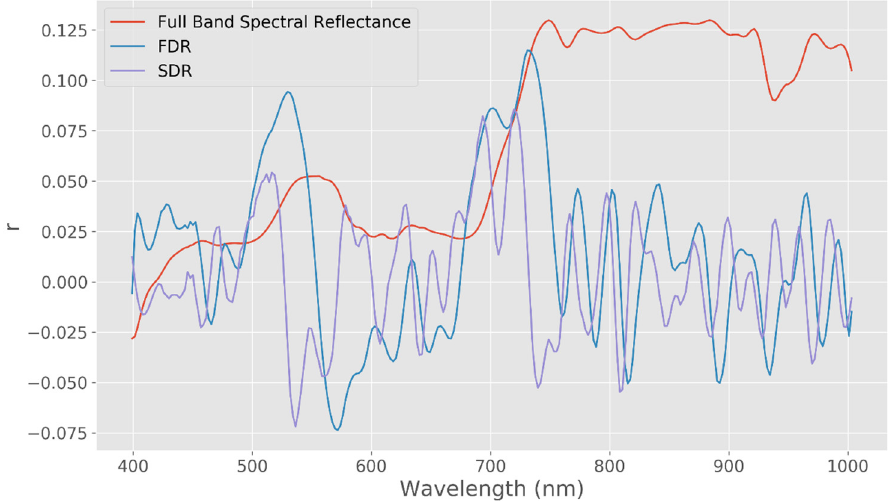
Figure 4. Pearson correlations between the spectral information and maize grain yield. The correla- tions were calculated for each spectral band at individual data collections. The averaged correlations over all the dates are shown in the plot.